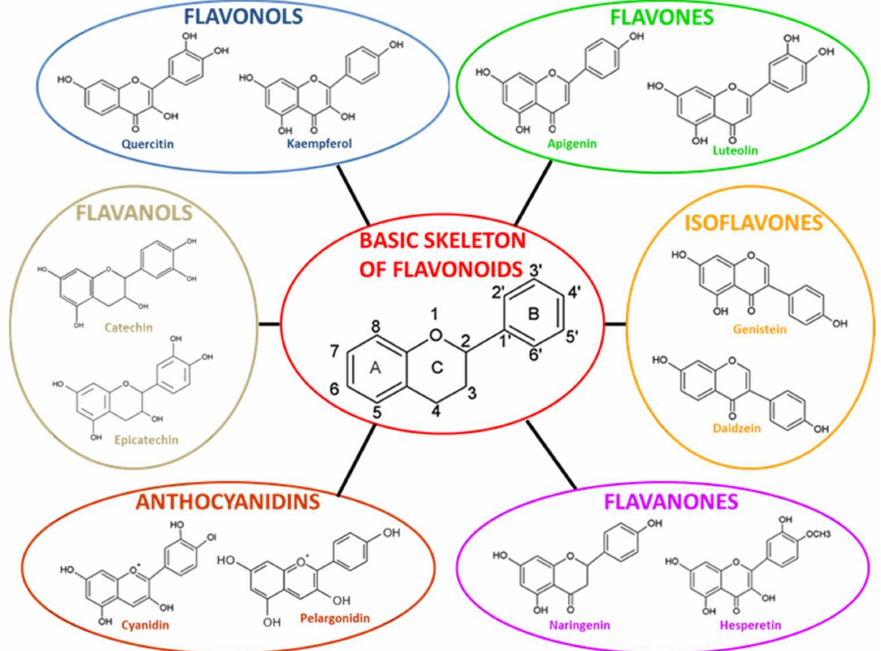
Figure 1. Basic skeleton structure of flavonoids and its subclasses. Adapted with permission from [38]. 2021, Giuseppe